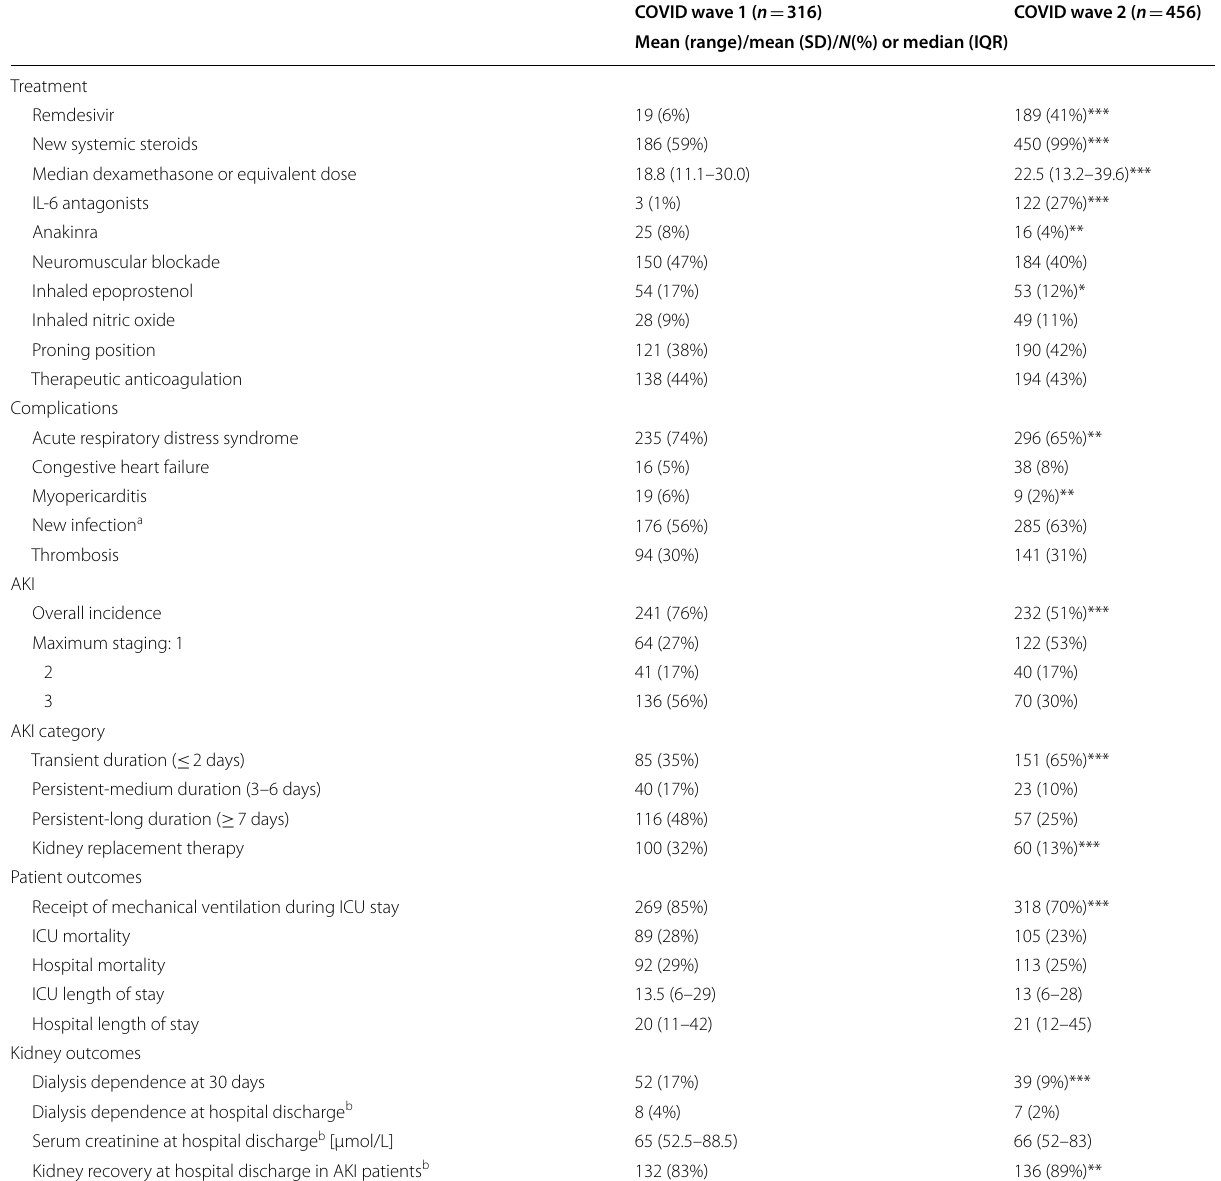
Table 2 Complications, treatments, AKI and ICU outcomes, stratified by wave